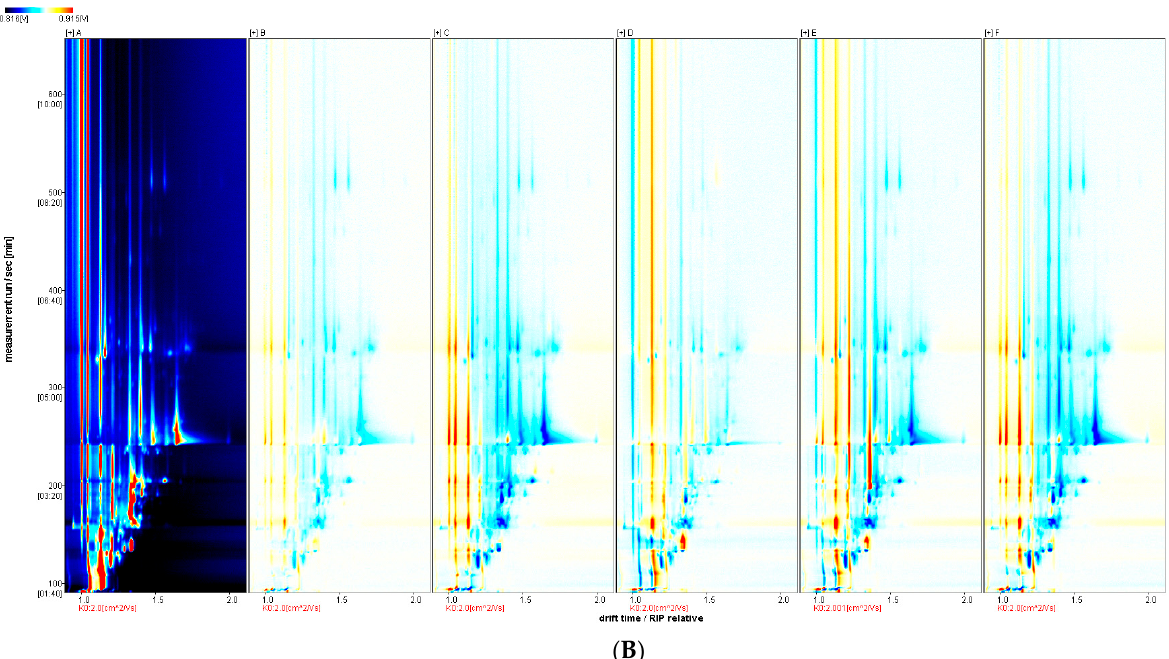
Figure 11. GC-IMS two-dimensional spectra of flavour volatiles resulting from different vanillin treatment concentrations on crucian carp muscle. Note: ( A ): top view; ( B ): difference plot. From left to right: 0, 0.50, 0.75, 1.00, 1.25, and 1.50 g/L vanillin. The GC retention time and IMS migration time of the volatile flavour compounds from carp muscle after treatment, with different concentrations of vanillin, were com- pared with the GC-IMS database on crucian carp muscle volatiles. The library search identified 40 flavour compounds (Figure 12, Table 4), including eight aldehydes, 11 alco- hols, 10 ketones, two esters, and one furan.